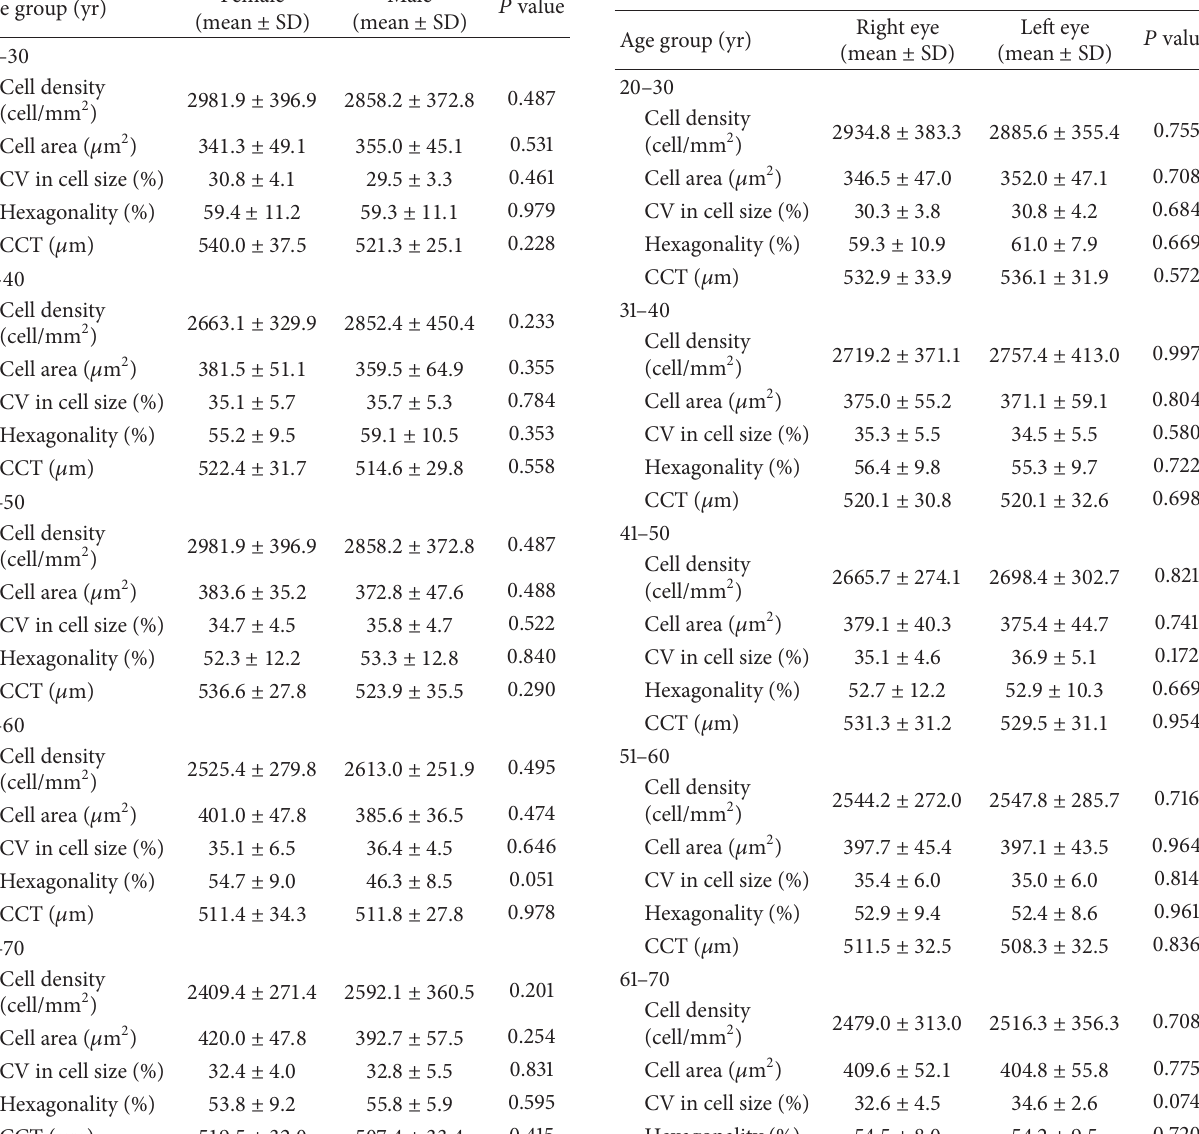
Table 2: Endothelial cell characteristics in female and male. Table 3: Corneal endothelial characteristics in right and left eyes of subjects.